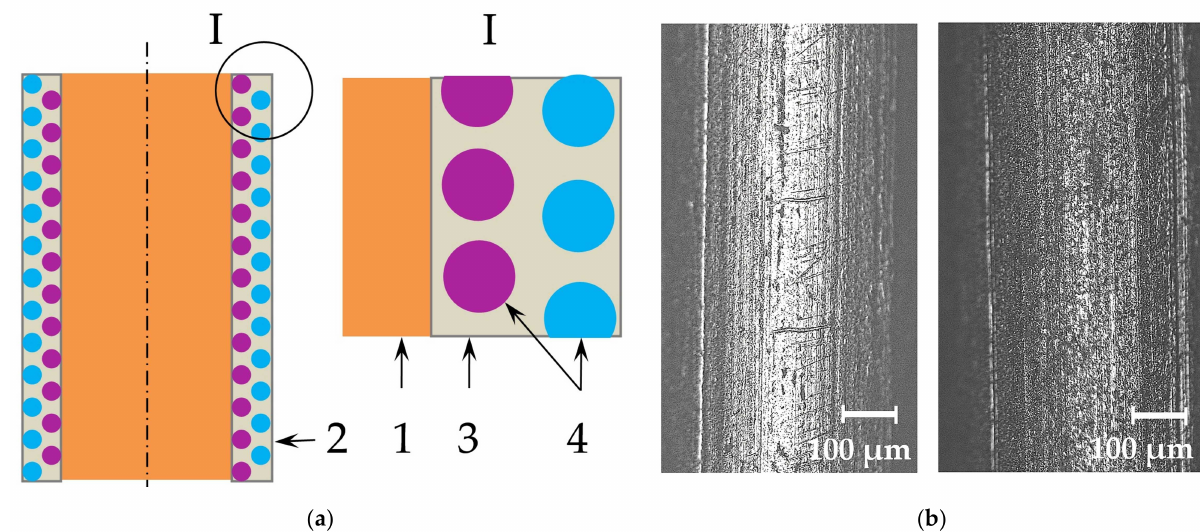
Figure 12. ( a ) The design of the composite wire: (1) solid wire, (2) composite coating, (3) metal matrix, (4) particles of rare earth compounds, ( b ) optical macrostructure of the surface of G3Si1 wire with Ni-LaF 3 coating; ( c ) optical macrostructure of the surface of G3Si1 wire with Ni-LaB 6 coating.